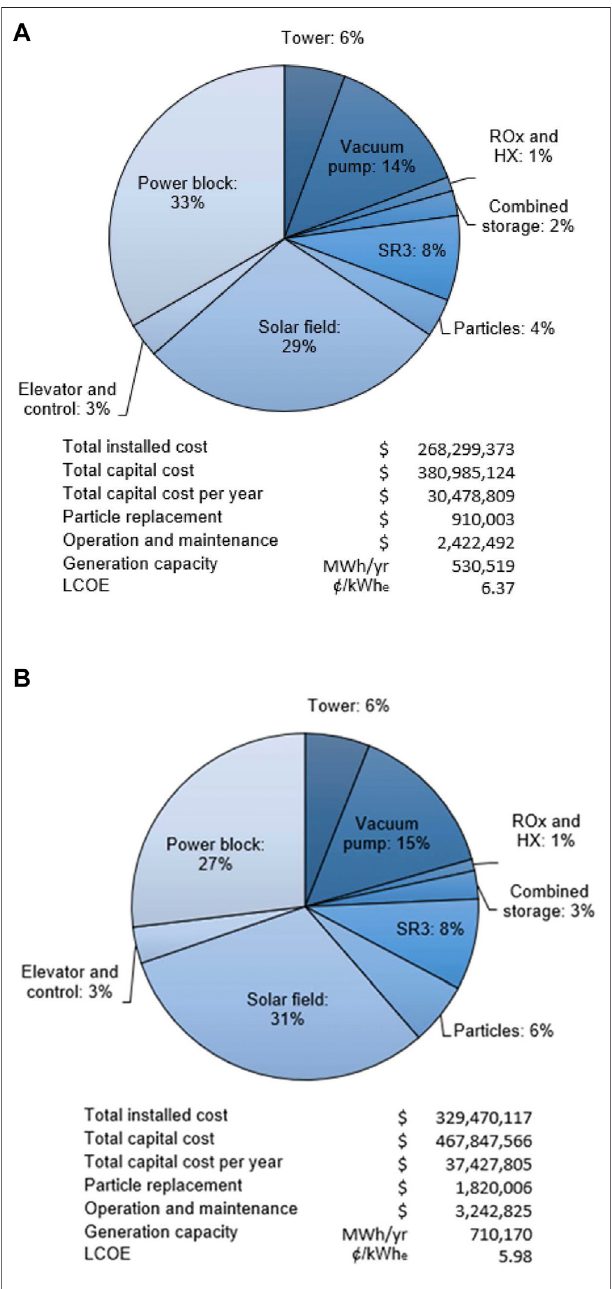
FIGURE6 |(A) Cost breakdown and LCOE for baseline system with6 h of storage and SM (cid:2) 1.8, and (B) lower LCOE case with 12 h of storage and SM (cid:2)